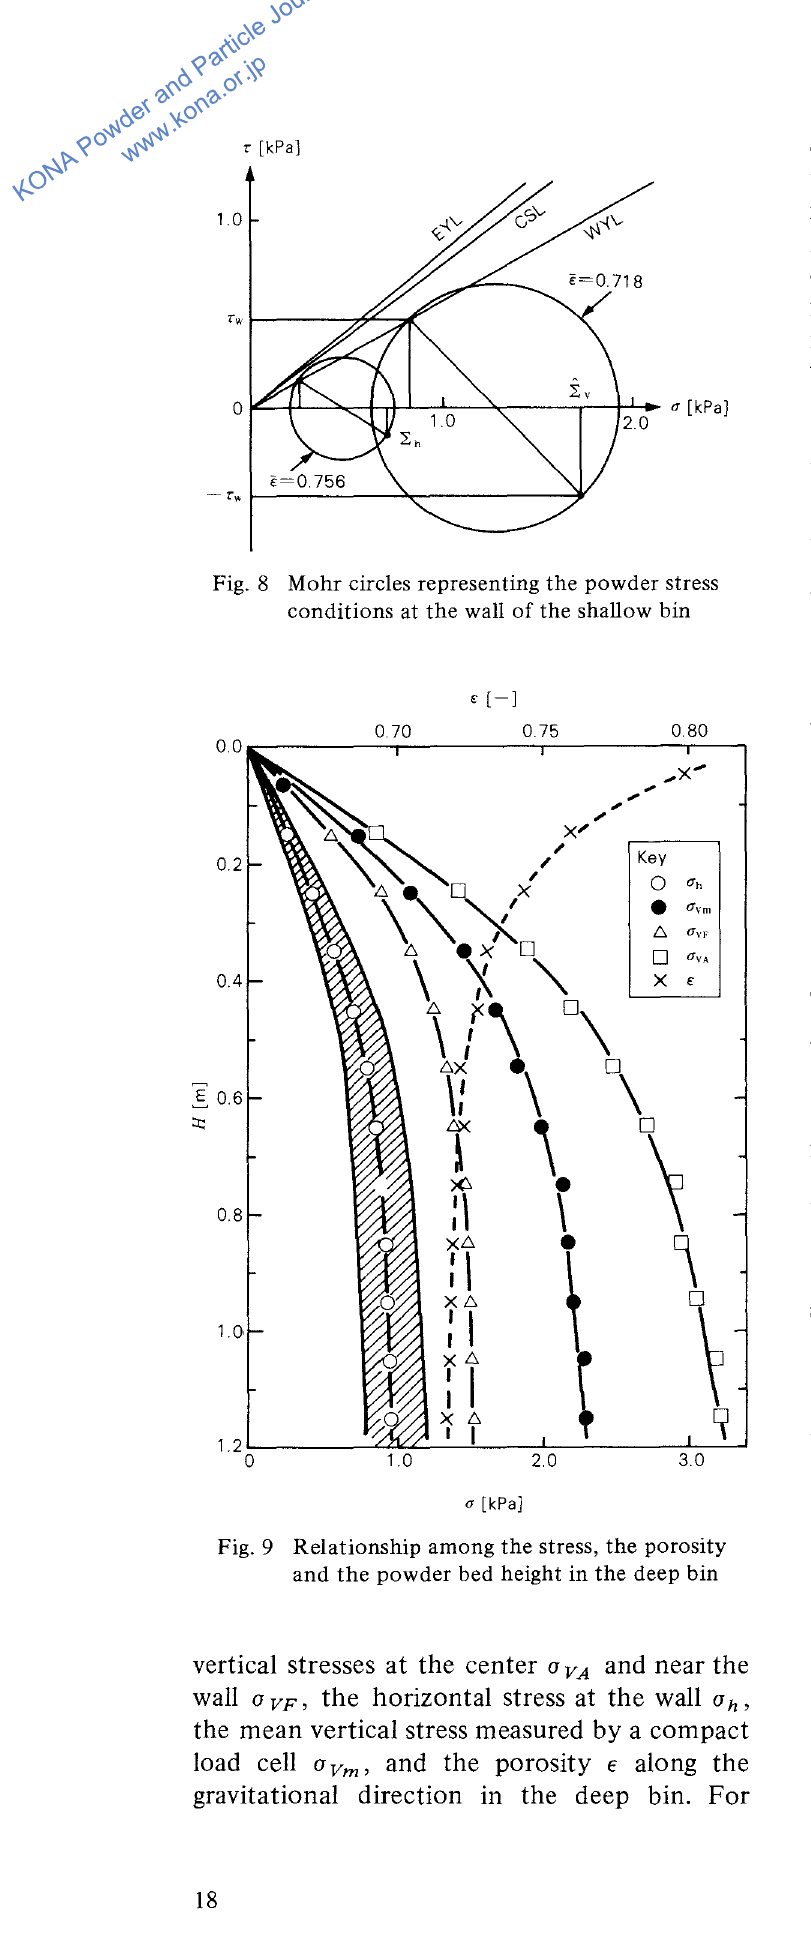
vertical stresses at the center a VA and near the wall a vF, the horizontal stress at the wall a h , the mean vertical stress measured by a compact load cell a vm, and the porosity E along the gravitational direction in the deep bin.